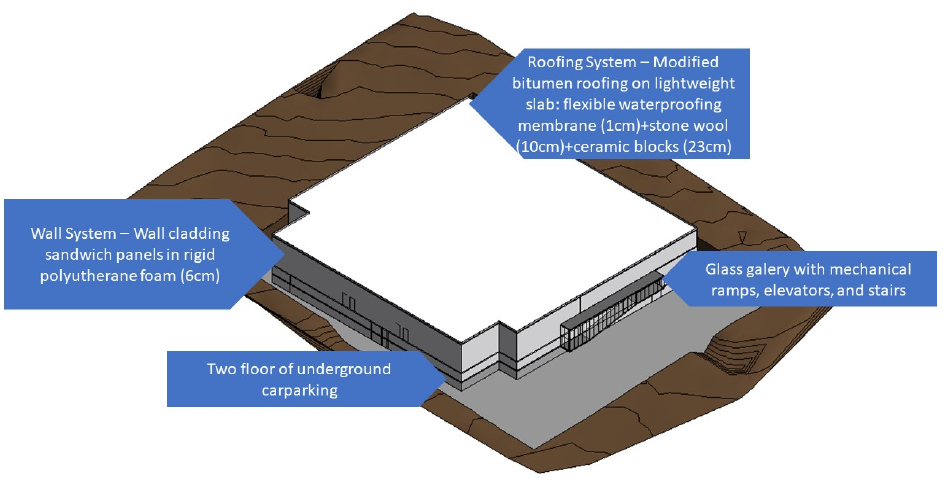
Figure 4. Case study’s building modelling in software REVIT ® with shell building material specifications. Table 1. Building materials used in the envelope of the case study.